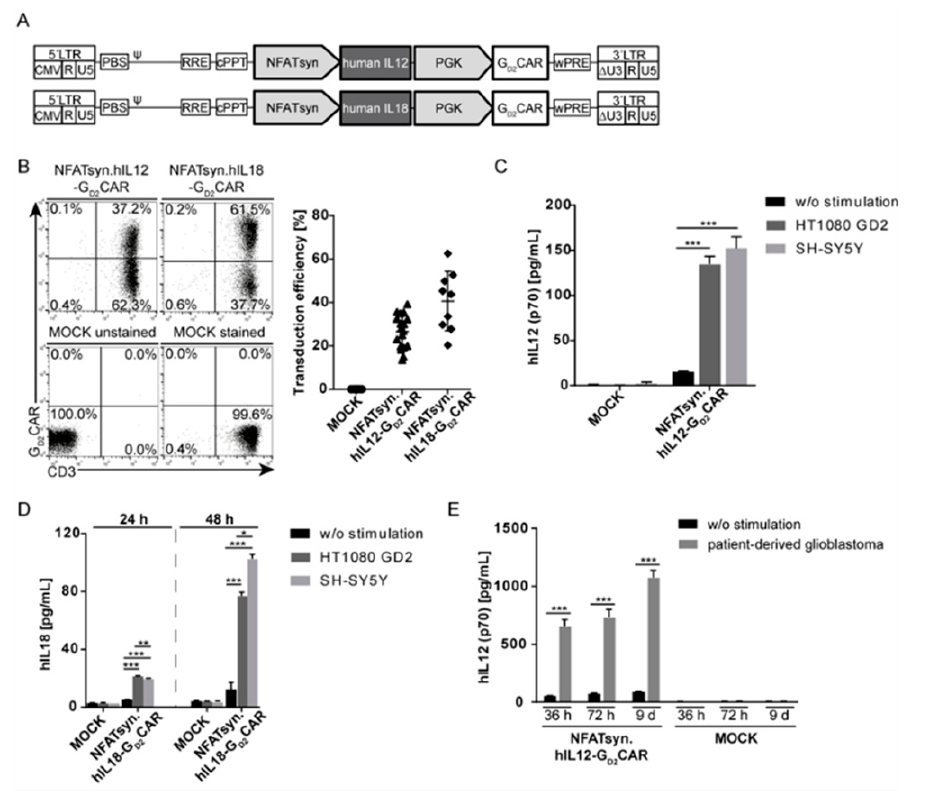
Figure 5. E ff ective human interleukin (IL)12 and human IL18 secretion after CAR-specific Figure 5 . Effective human interleukin (IL)12 and human IL18 secretion after CAR-specific stimulation. ( A ) Schematic design of the “all-in-one” NFATsyn.hIL12-G D2 CAR and NFATsyn.hIL18-G D2 CAR constructs. Indicated is the inducible promoter (NFATsyn). ( B ) Representative flow cytometric